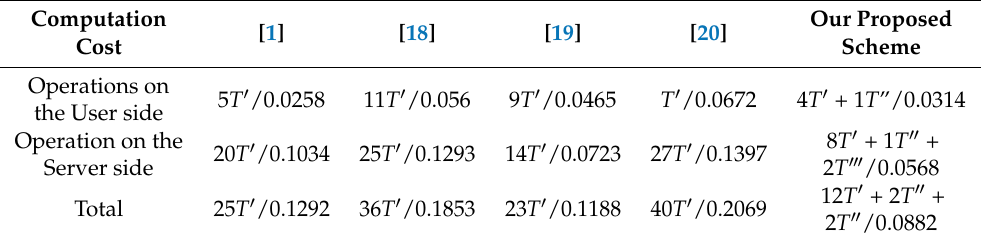
Table 4. Comparisons of performance analysis based on computation time with other state-of-art works ( T 1 : Computation time to compute the one hash function, T 1 : Time in encryption and decryption algorithms, T 3 Time in digital